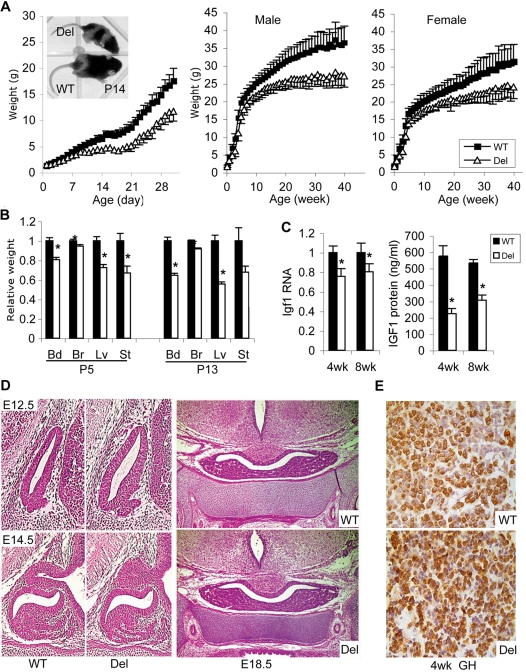
Growth and somatic development of Snord116del mice.A. Daily weight curves for males (left) and weekly weight curves for males (middle) and females (right). The female weight curve in the first month (not shown) overlaps with the male curve. Error bars, standard deviations. Significant weight differences between Snord116del mice and their WT littermates ranged from P<0.05 in young pups, after postnatal day 2 (P2), to P<1 ×10−8 after 6 months (n = 15∼20 in each sex/genotype group). Insert photo: Snord116del (top) and WT (bottom) pups at P14. B. Comparison of body and organ weights in Snord116del mice and WT littermates at P5 and P13 (P5: n = 27 WT, 24 Del; P13: n = 8 WT, 9 Del). Error bar: SEM. At P5, all differences were significant at P<0.003 except for brain at P<0.02. At P13, all differences were significant at P<0.0001 except for stomach, P = 0.05. Bd: body, Br: brain, Lv: liver, St: stomach. C. Levels of Igf1 transcripts in liver and IGF-I protein in serum are reduced in deletion mice. Left: Liver RNA from 4-week old (n = 9 WT, 7 Del) and 8-week old (n = 8 WT, 8 Del) mice were assayed by qRT-PCR with Gapdh levels as internal control. WT levels were set at 1. Error bar: SEM. Asterisks: P<0.05. Right: Serum levels of IGF-I protein from the same group of mice were measured by ELISA. Asterisks: P<0.0005. D. Hematoxylin and eosin stained sagittal sections of the pituitary at E12.5 and E14.5 (left WT, middle Del) and coronal sections at E18.5 (right) revealed normal pituitary size and structure. E. Immunohistochemical staining for growth hormone (somatotrophs) revealed no detectable differences in WT (top) and Del (bottom) mice at 4 weeks of age.